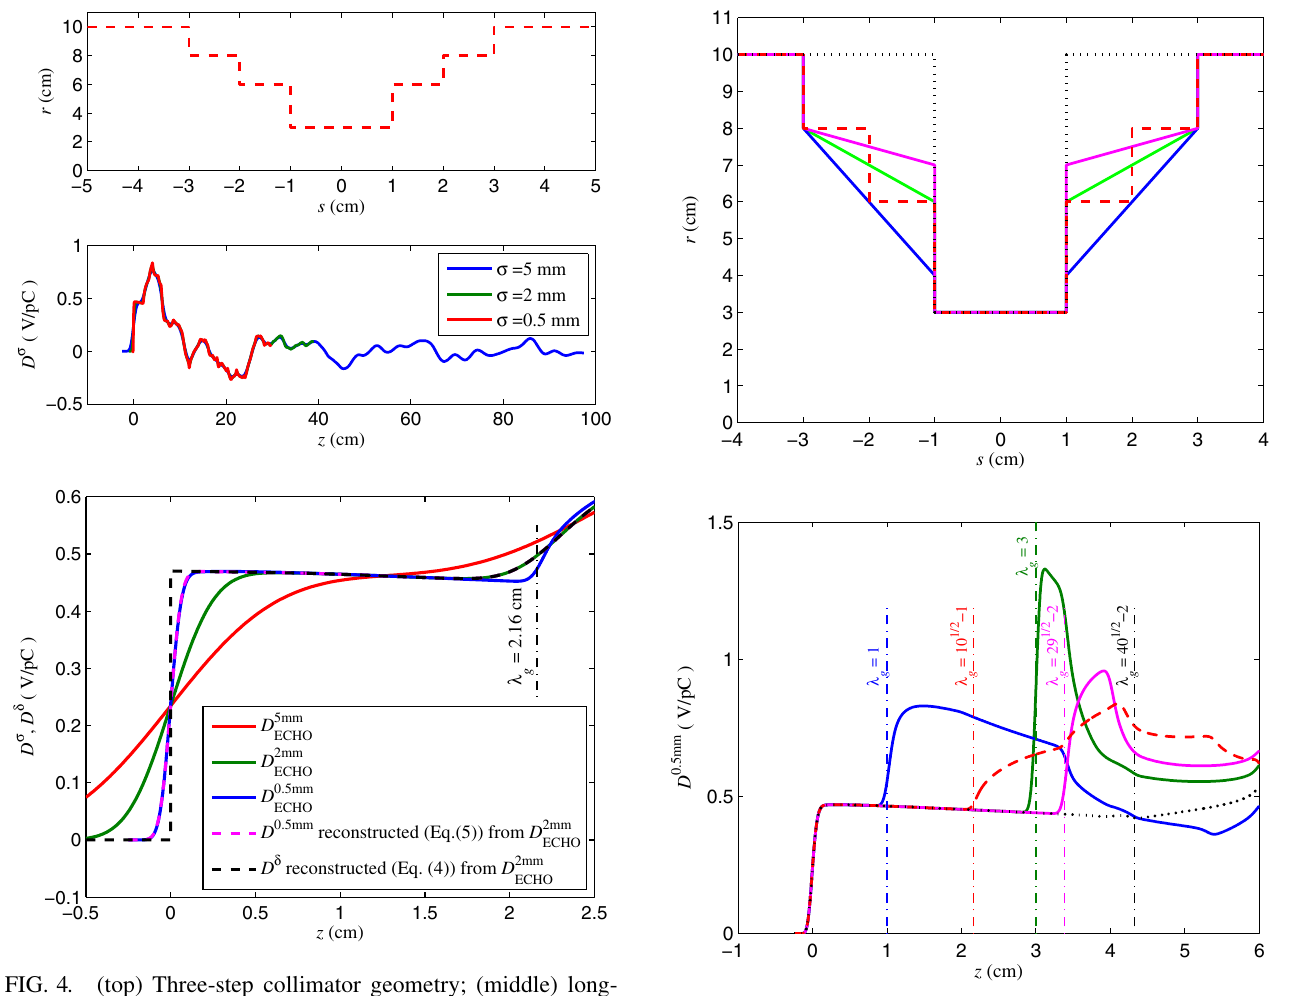
curve, with D (cid:4) ð 0 þÞ (cid:2) 0 : 48 V = pC , for which a zoomed-in